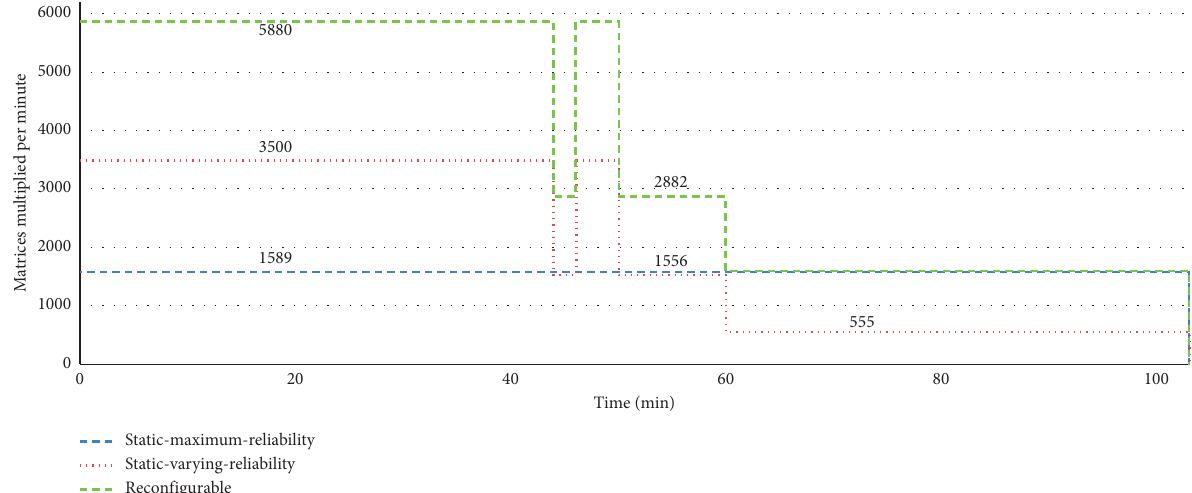
Figure 11: Performance results for static-maximum-reliability, static-varying-reliability, and reconfigurable configurations of the matrix